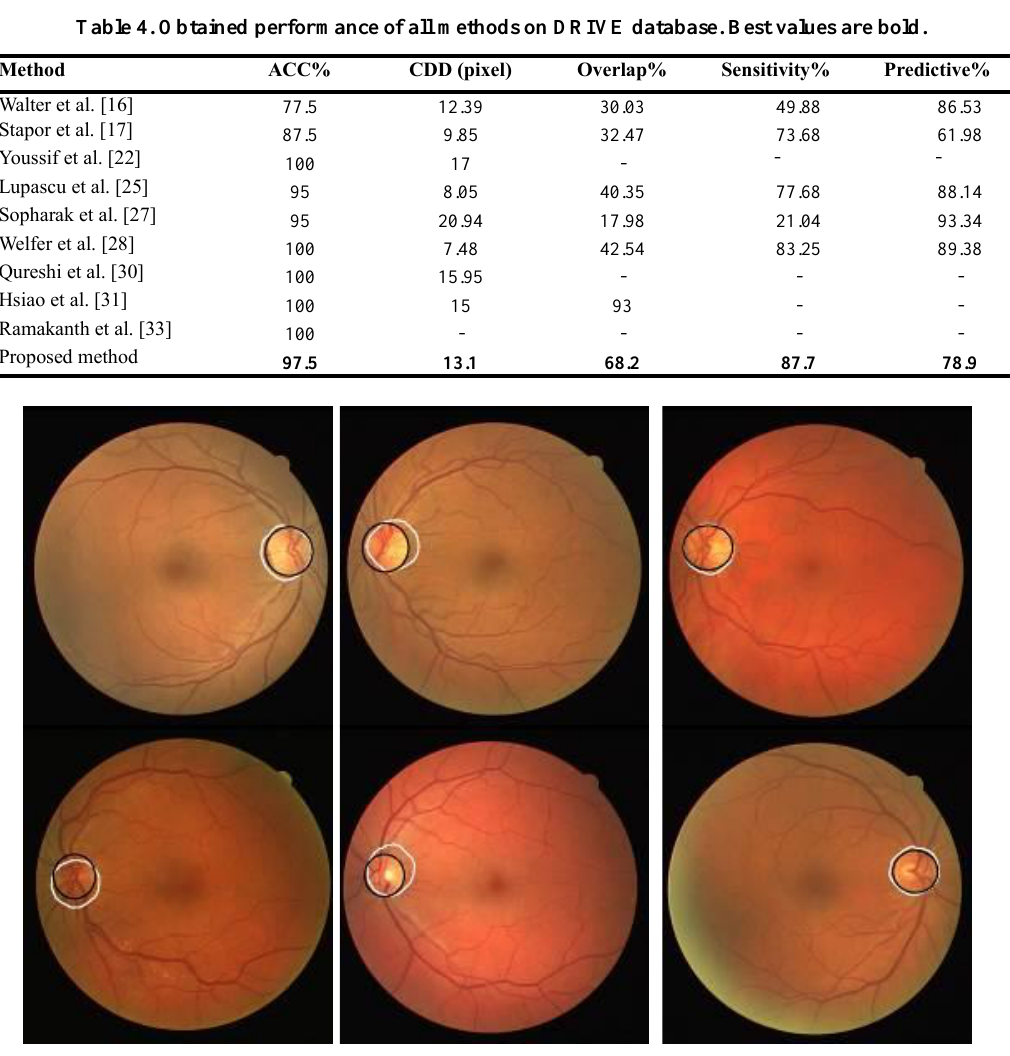
Figure 11. Results obtained for proposed method on some images of DRIVE dataset. Detected boundary of optic disc is shown by white curve, and corresponding ground truth is shown by black curve. Table 5. Running times for different segmentation methods on DRIVE database. Best values are